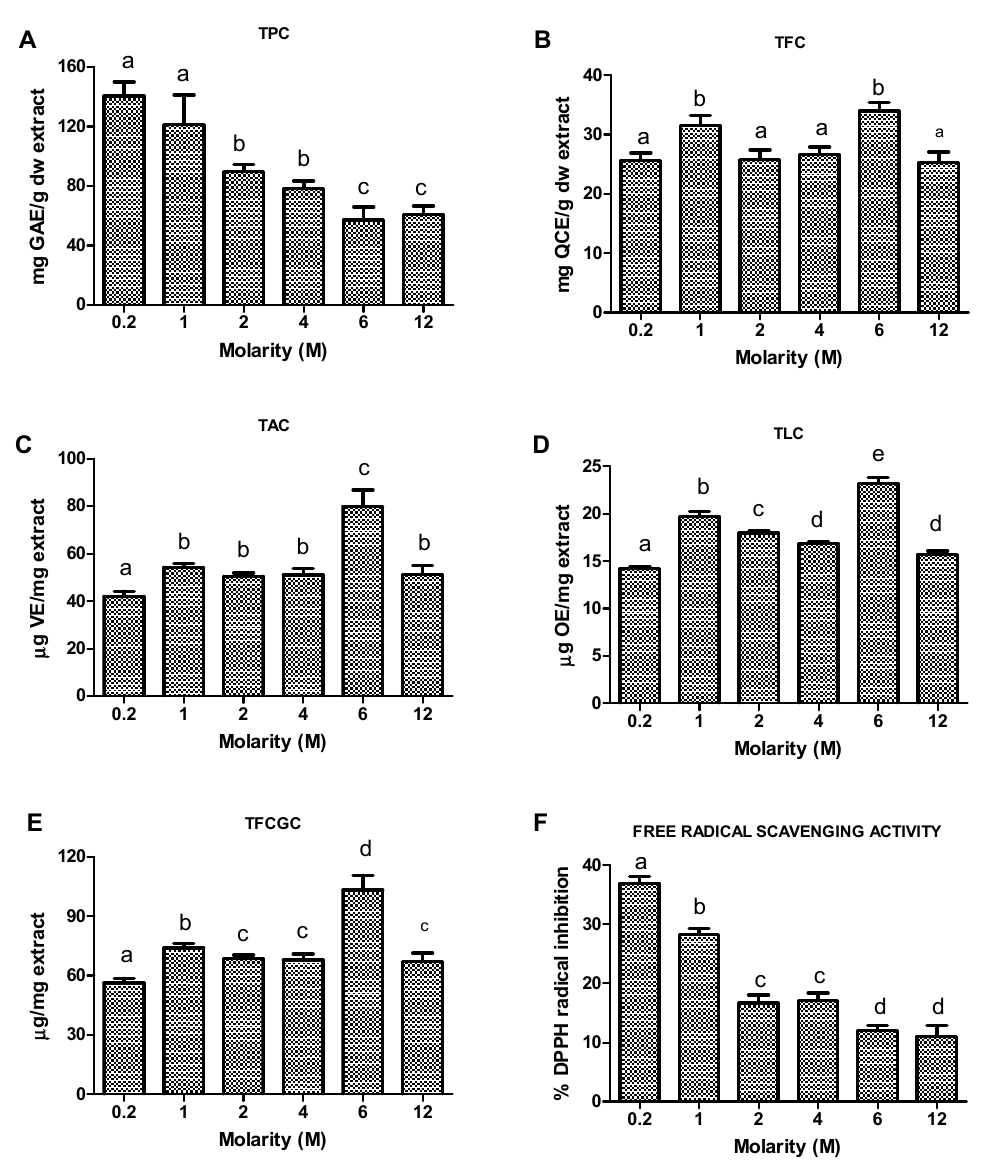
Figure 7. Effects of acid molarity on the acid hydrolysis for TPC ( A ), TFC ( B ), total apigenin content (TAC) ( C ), total luteolin content (TLC) ( D ), total flavonoid C -glycoside content (TFCGC) ( E ), and DPPH free radical scavenging activity ( F ). Different letters indicate significant difference between tested parameters ( p < 0.05). DW stands for dried weight.